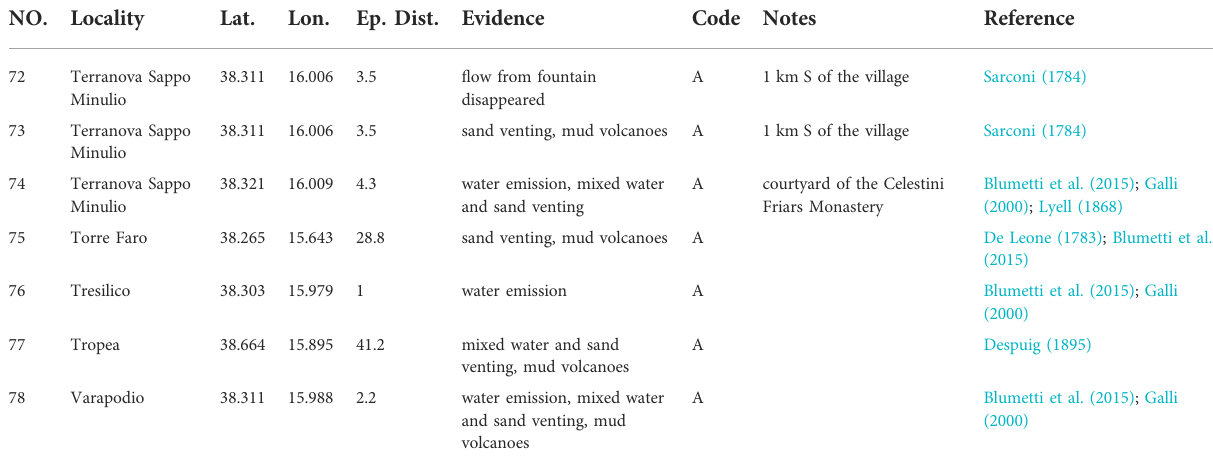
TABLE2( Continued )Listofthehydrologicaleffectsassociatedwiththe1783earthquake(progressive numbercorrespondstoFig.5).Theattributionof the quality code to the 78 effects is based on the reliability of the reference/account associated with the observation (see main text). The epicentral distance (in kilometers) is calculated from the location of the Italian seismic Catalogue (Rovida et al., 2021).